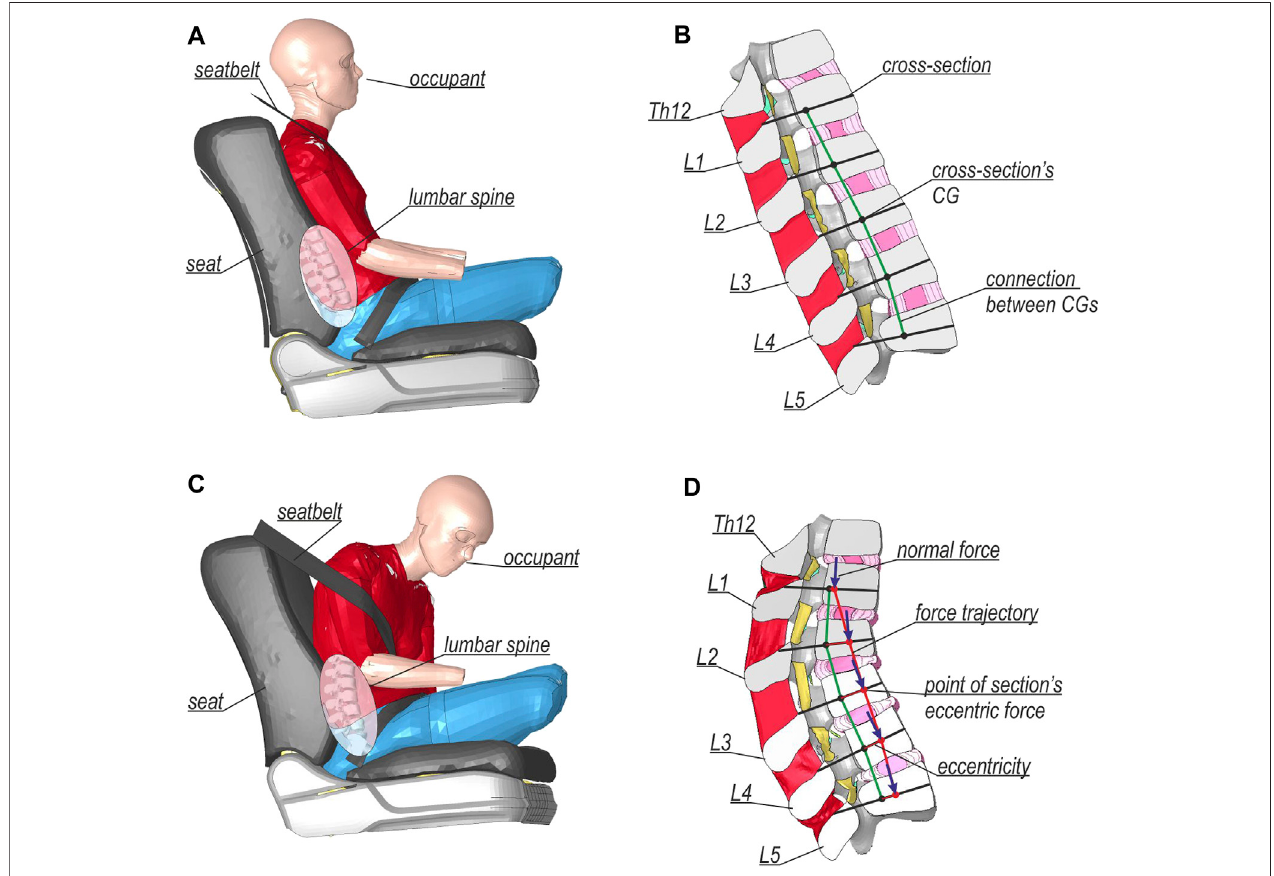
TABLE 2 | The internal forces, eccentricities and LSIs of speci fi c vertebras during landing.